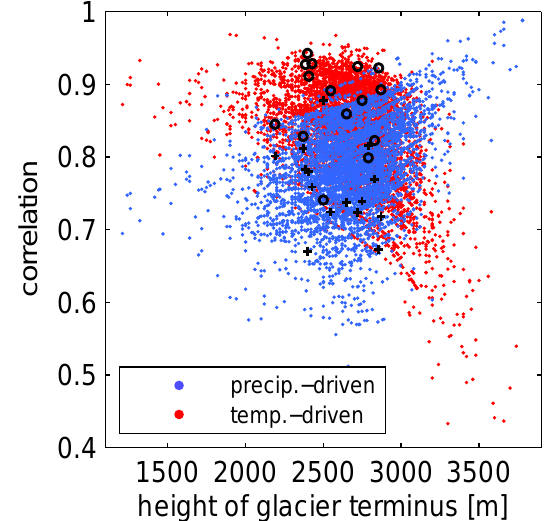
Fig. 11. Correlation between reconstructed mass balance variability and mass balance variability driven only by temperature variability (red) and mass balance variability driven only by precipitation vari- ability (blue), for all glacier within the Alps included in the WGI- XF, as a function of the terminus altitude. Circles (crosses) show the values of the measured glaciers included in the final set, corre- sponding to red (blue)